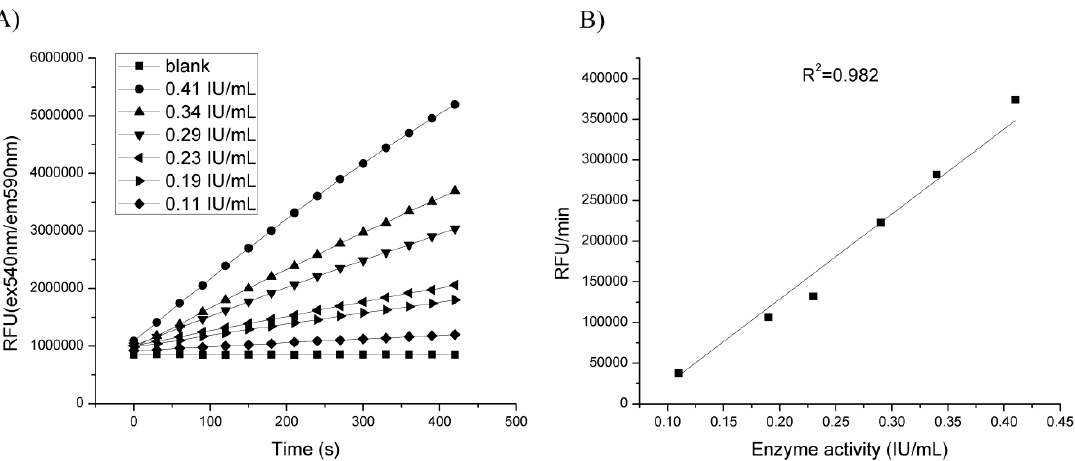
Figure 4. Dependence of fluorescence (RFU) change in time for different amounts of enzyme in 0.1 M sodium-phosphate at pH 5.5 and 10 mM lactose and 0.1 mM resazurin. ( A ) Reaction kinetics in time; ( B ) Calibration curve. Fluorescence measured at ex/em 540/590 nm.